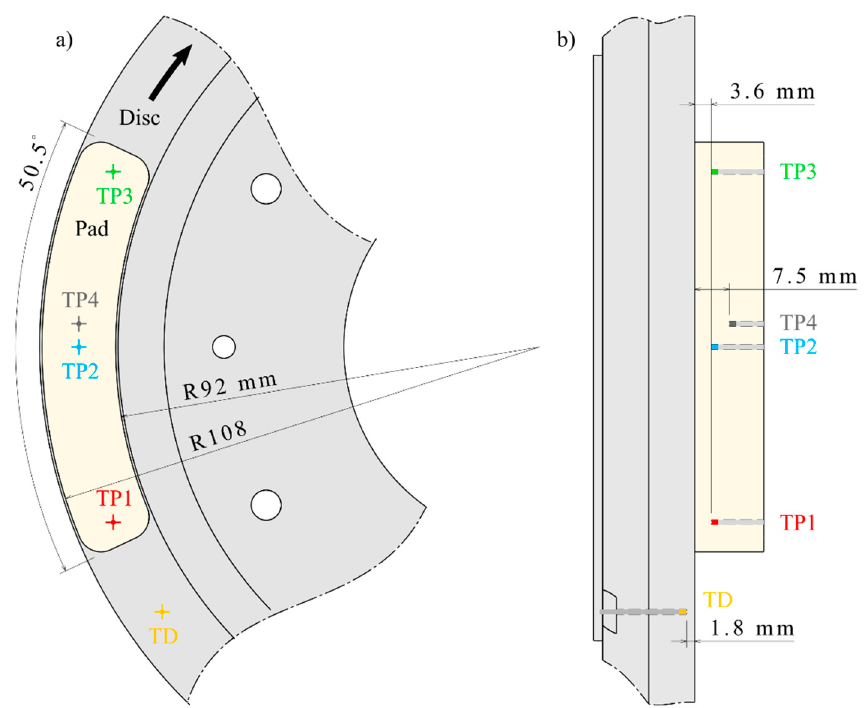
Figure 4. Details of the friction parts’ geometry and temperature measurements: ( a ) Front view; ( b ) side view.